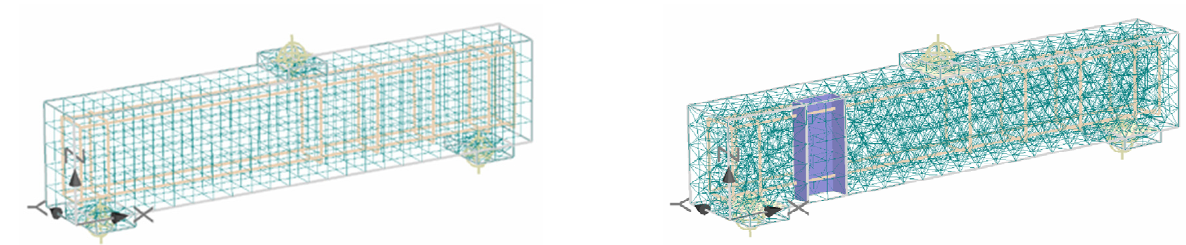
Figure 3. Equivalent uniaxial stress-strain of concrete.